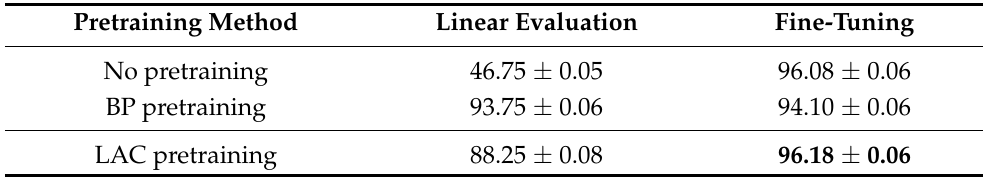
Table 1. Top-1 accuracy for classification of MNIST dataset after linear evaluation and fine-tuning. After pretraining AE to reconstruct MNIST images, the decoder is replaced by a fully connected layer to classify digits from 0 to 9. The best results are in bold.